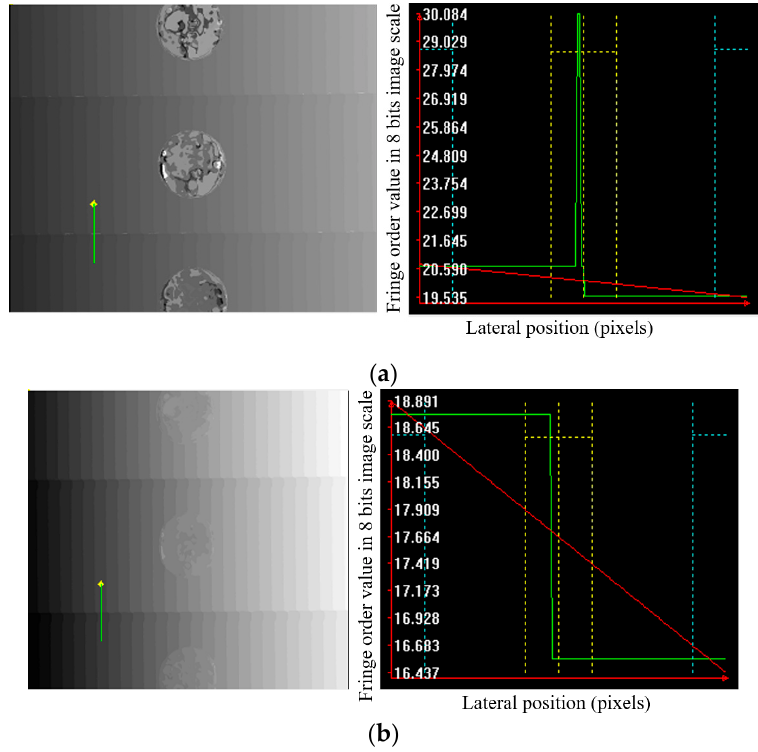
Figure 10. Captured image and its wrapped phase map with different projected patterns on semisphere target: ( a ) uniform light; ( b ) 121-pixel sinusoidal fringe pitch; ( c ) 12-pixel sinusoidal fringe pitch; ( d ) wrapped phase of ( b ); ( e ) wrapped phase of ( c ); ( f ) absolute height map calculated using proposed algorithm; ( g ) 3D profile; and ( h ) height cross-section of row 512 of ( f ).